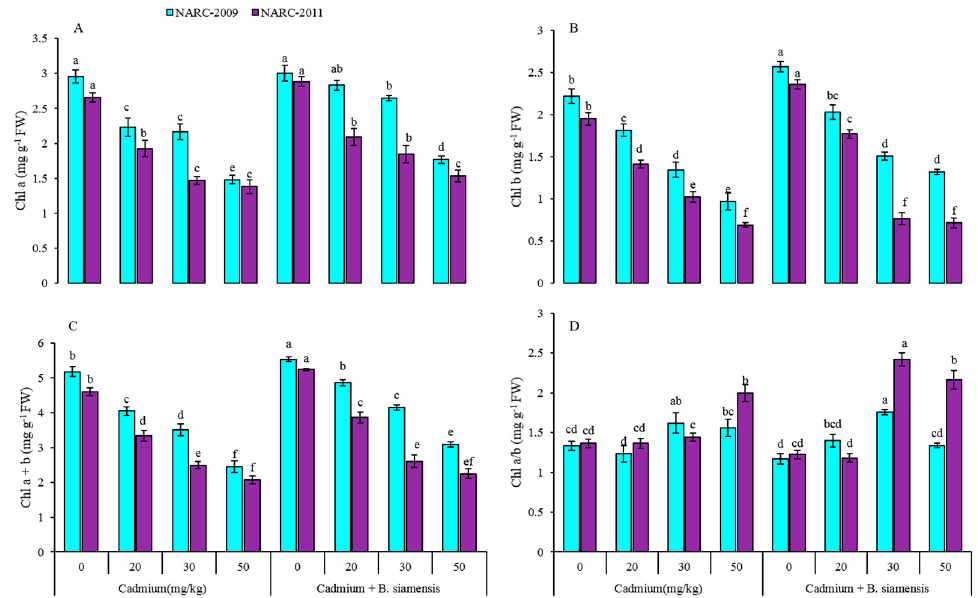
Figure 2. Effect of seed inoculation with Bacillus siamensis on chlorophyll a ( A ), chlorophyll b ( B ), chlorophyll a + b ( C ), and chlorophyll a / b ( D ) of two wheat varieties under Cd stress. Data are expressed as the means of three replicates. Bars show ± SD and different letters show a significant difference among treatments at 0.05 level.